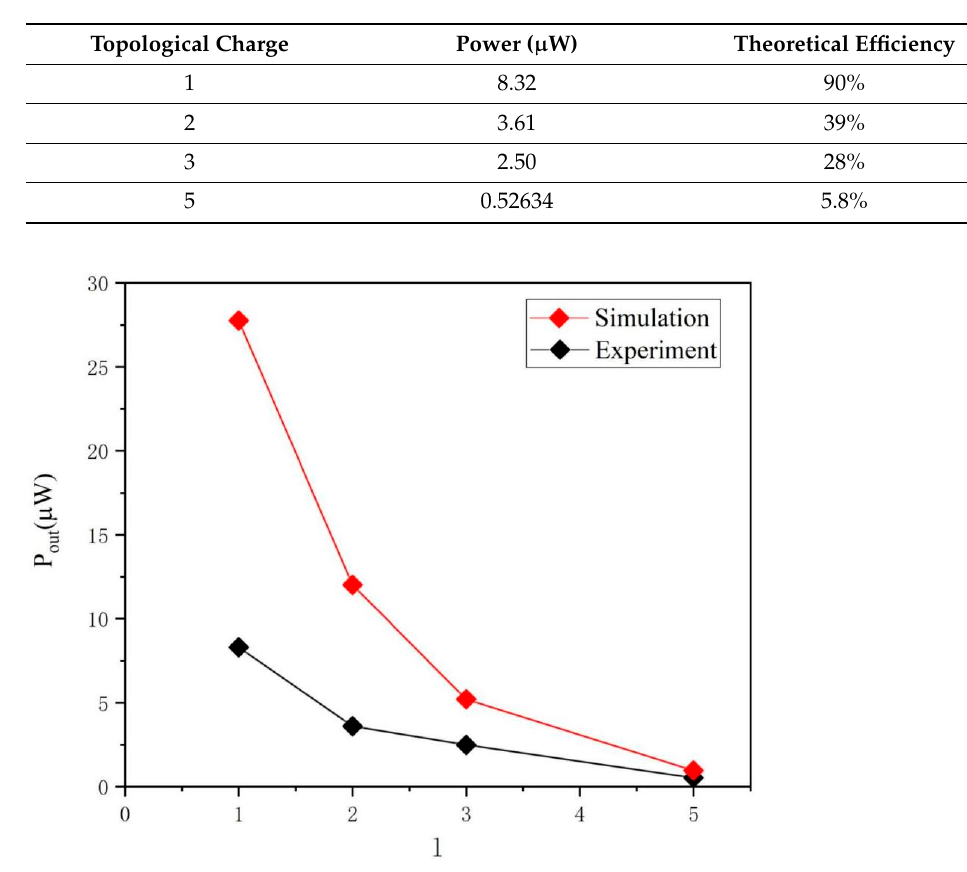
Figure 4. The experimental and theoretical output power of output light as a function of the topological charge of vortex light at 780 nm, where the pump power at 1950 nm is 180 mW and the power at 780 nm is 6 mW.